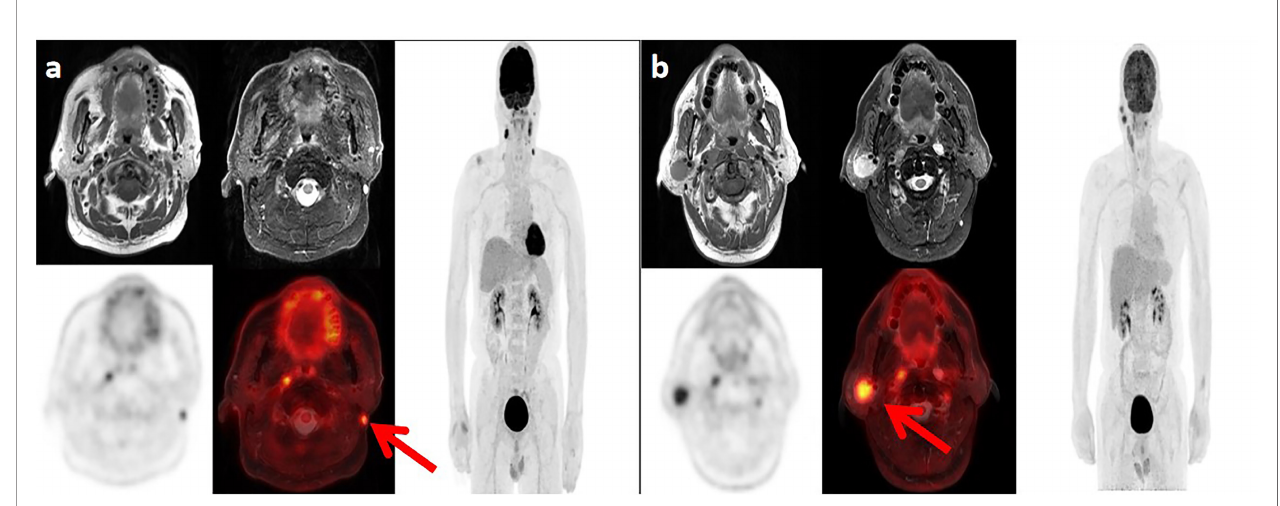
FIGURE 1 | Lymph node metastases in two patients with nasopharyngeal carcinoma. (A) Positron emission tomography (PET)/magnetic resonance imaging (MRI) in a 62-year-old man show the left level Xa lymph node metastasis. (B) PET/MRI in a 47-year-old man show the right level VIII lymph node metastasis.